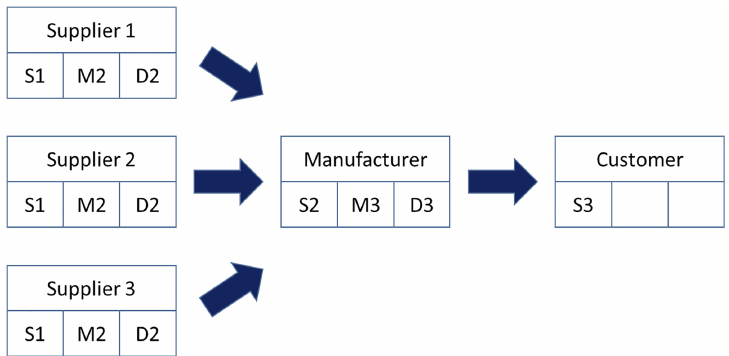
Figure 1. Supply chain for the procurement, production and distribution of customer-specific products (according to the SCOR